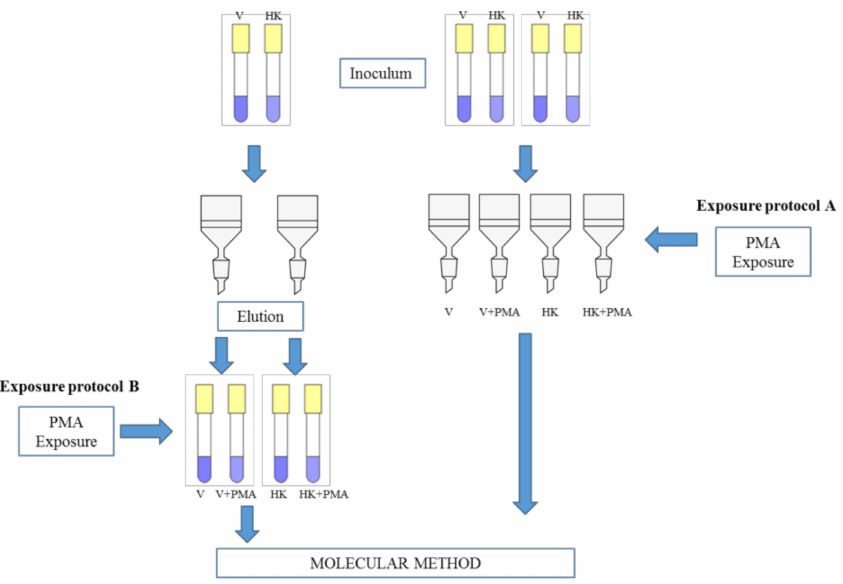
Figure 1. Scheme of the exposure protocols used. V: viable Leginonella pneumophila ; HK: heat-killed Leginonella pneumophila ; PMA: propidium